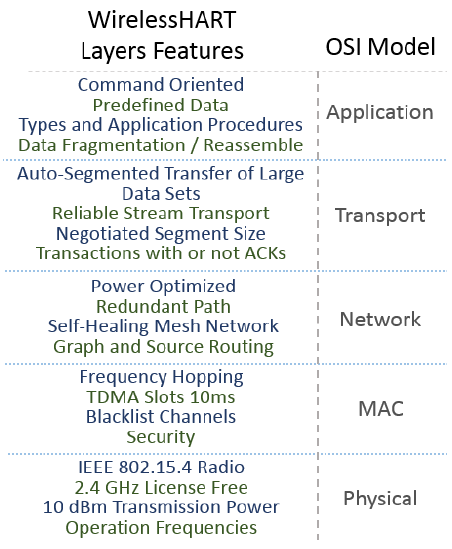
Figure 12. WirelessHART Protocol